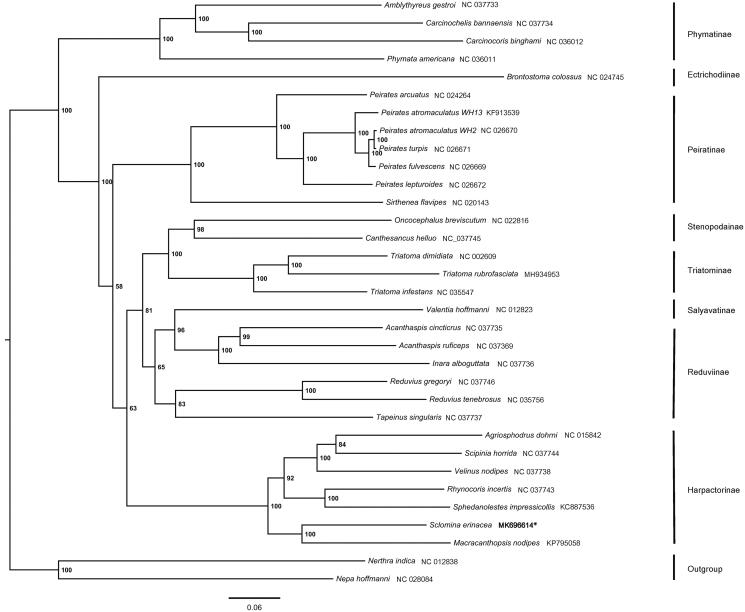
Phylogenetic relationship of Sclomina erinacea and other 32 species among Reduviidae. Phylogenetic tree was inferred from ML analysis of the 13 protein-coding genes and two rRNAs genes (12,812 bp) and generated by IQ-TREE 1.6.5 (Trifinopoulos et al. 2016) under the GTR + I + G model. The number beside the nodes are percentages of 1000 bootstrap values. The GenBank accession number of the species is shown behind the species name. The newly sequenced mitogenome is highlighted by the asterisk.